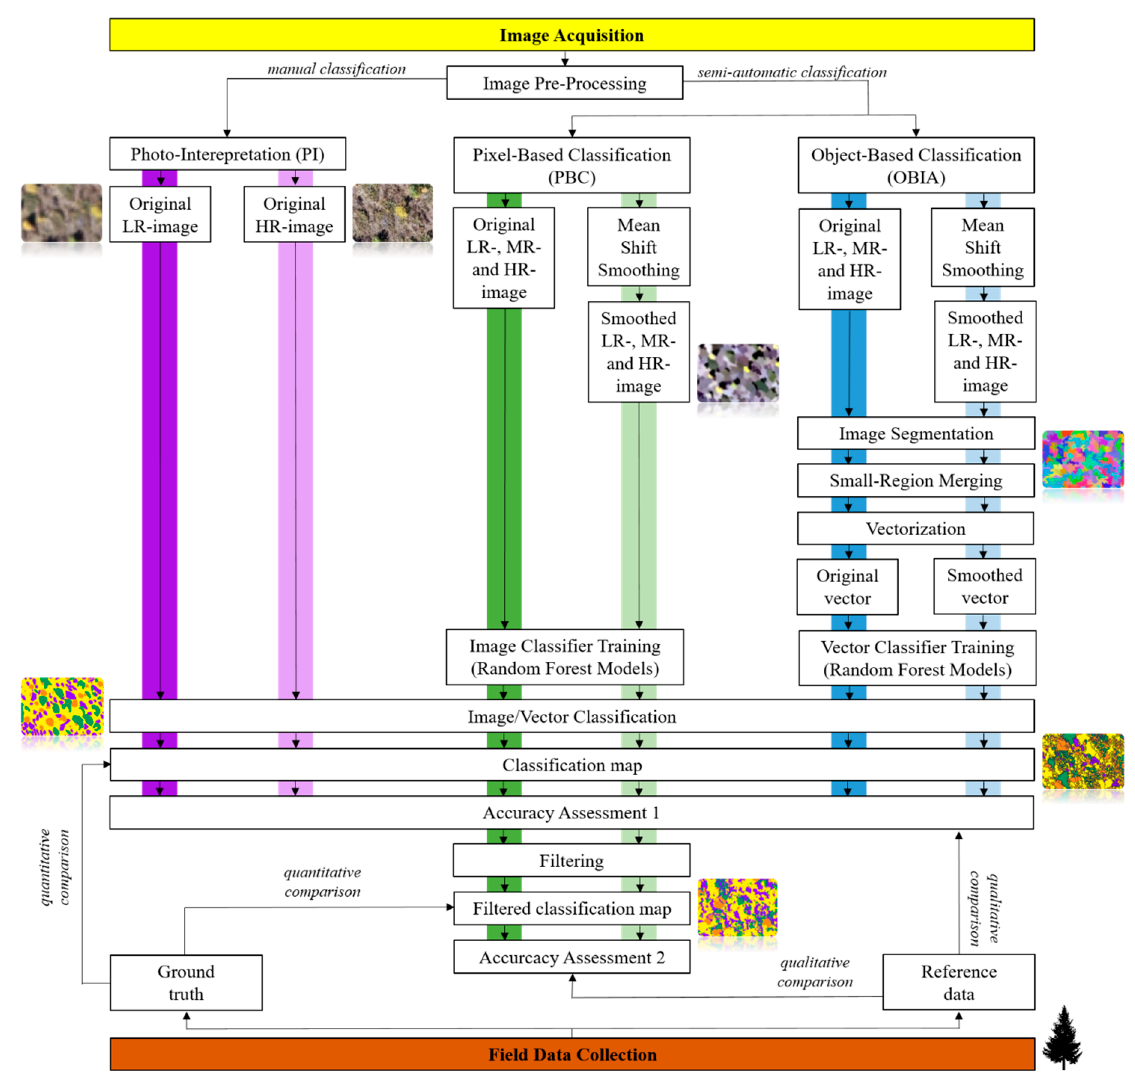
Figure 7. Workflow of the three image classification methods analyzed in this study.